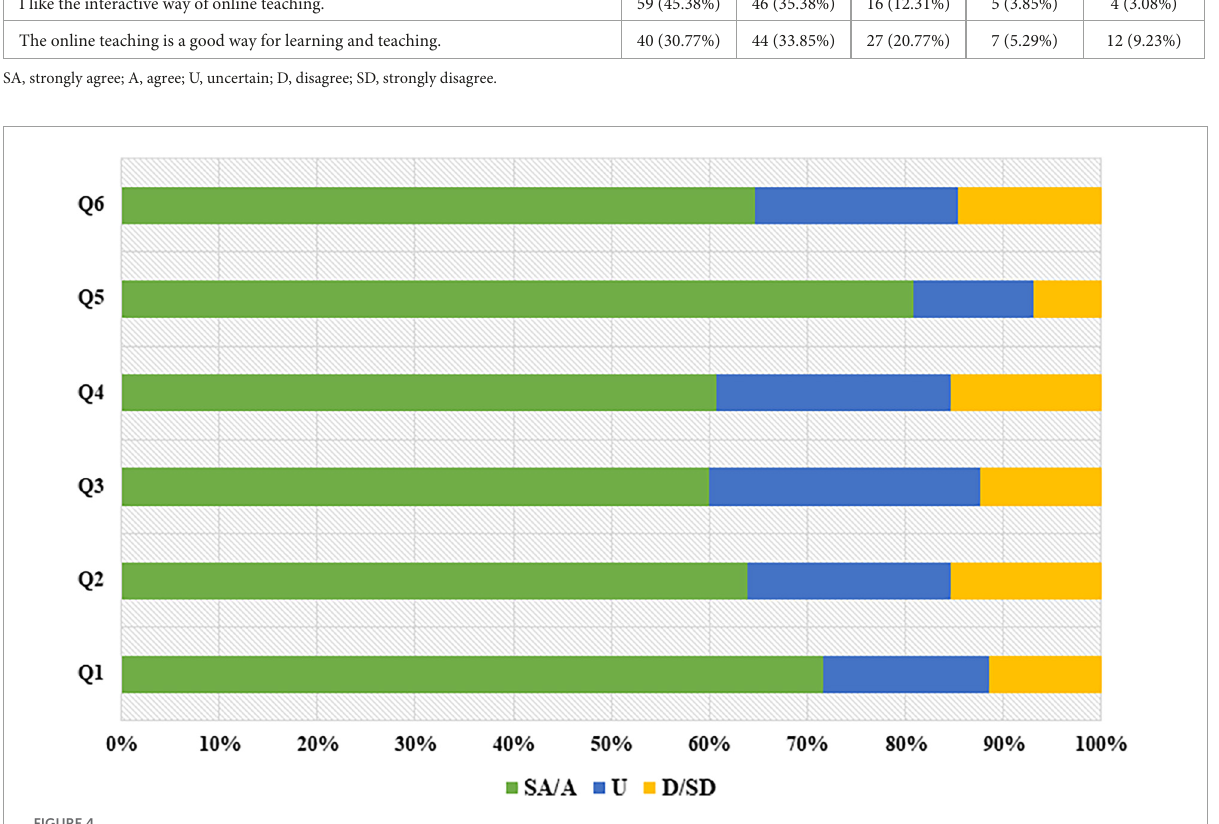
FIGURE4 Students’ attitudes toward this novel online teaching mode ( n = 130). SA, strongly agree; A, agree; U, uncertain; D, disagree; SD, strongly disagree. Q1 to Q6 represent the 6 questions in Table 2